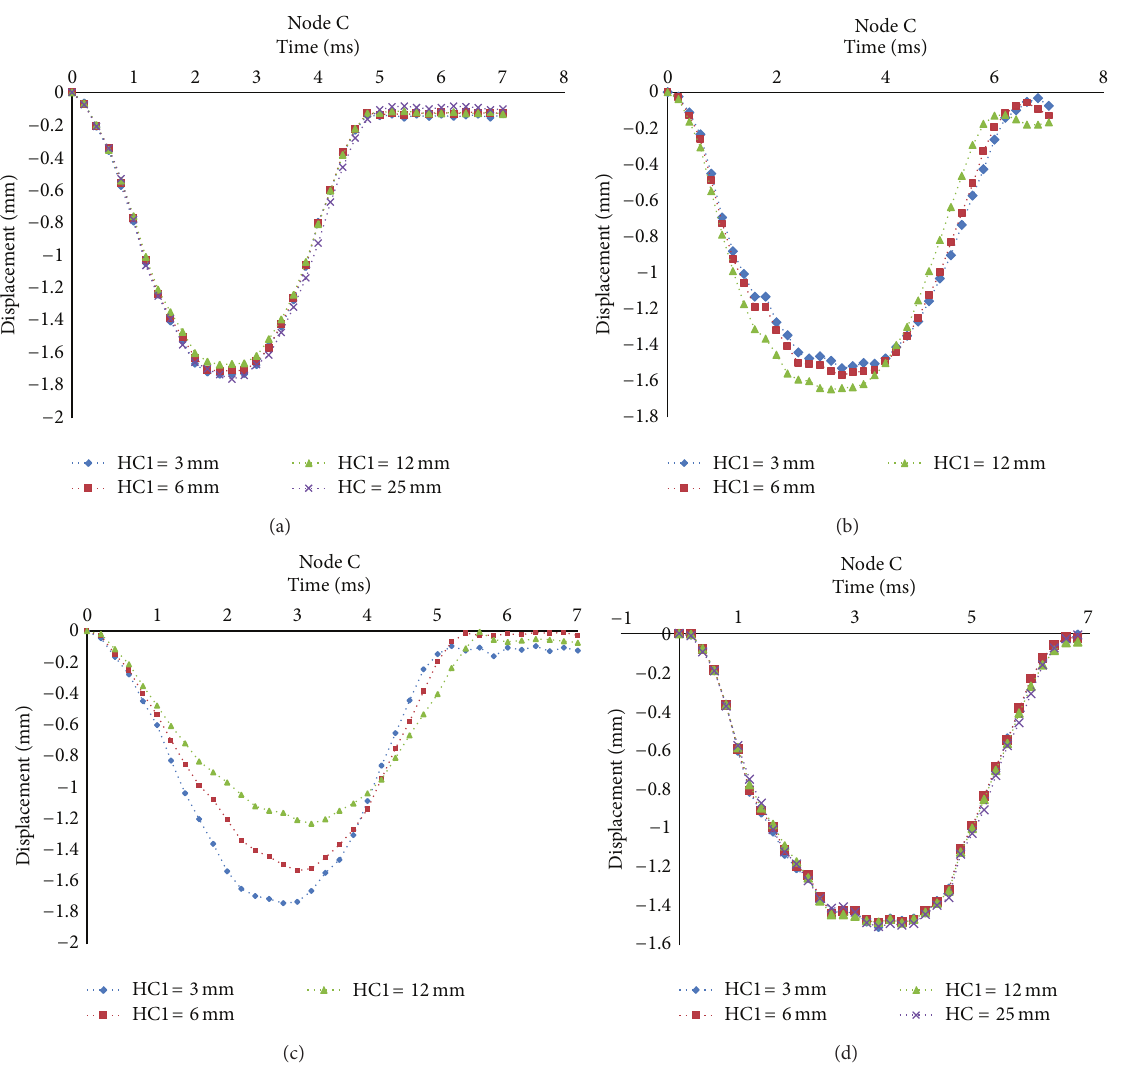
Figure 8: Deflection of target in different locations of the internal sheet: (a) Case 1: EPP-EPP; (b) Case 2: EPP-PUR; (c) Case 3: PUR-EPP; (d) Case 4: